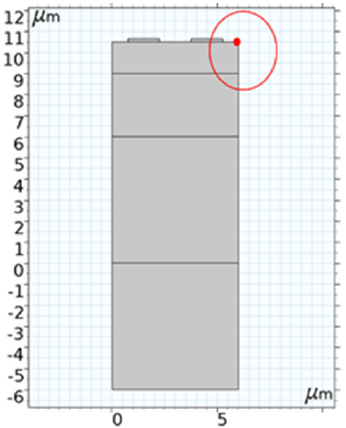
Figure 8. Position of total displacement probe.